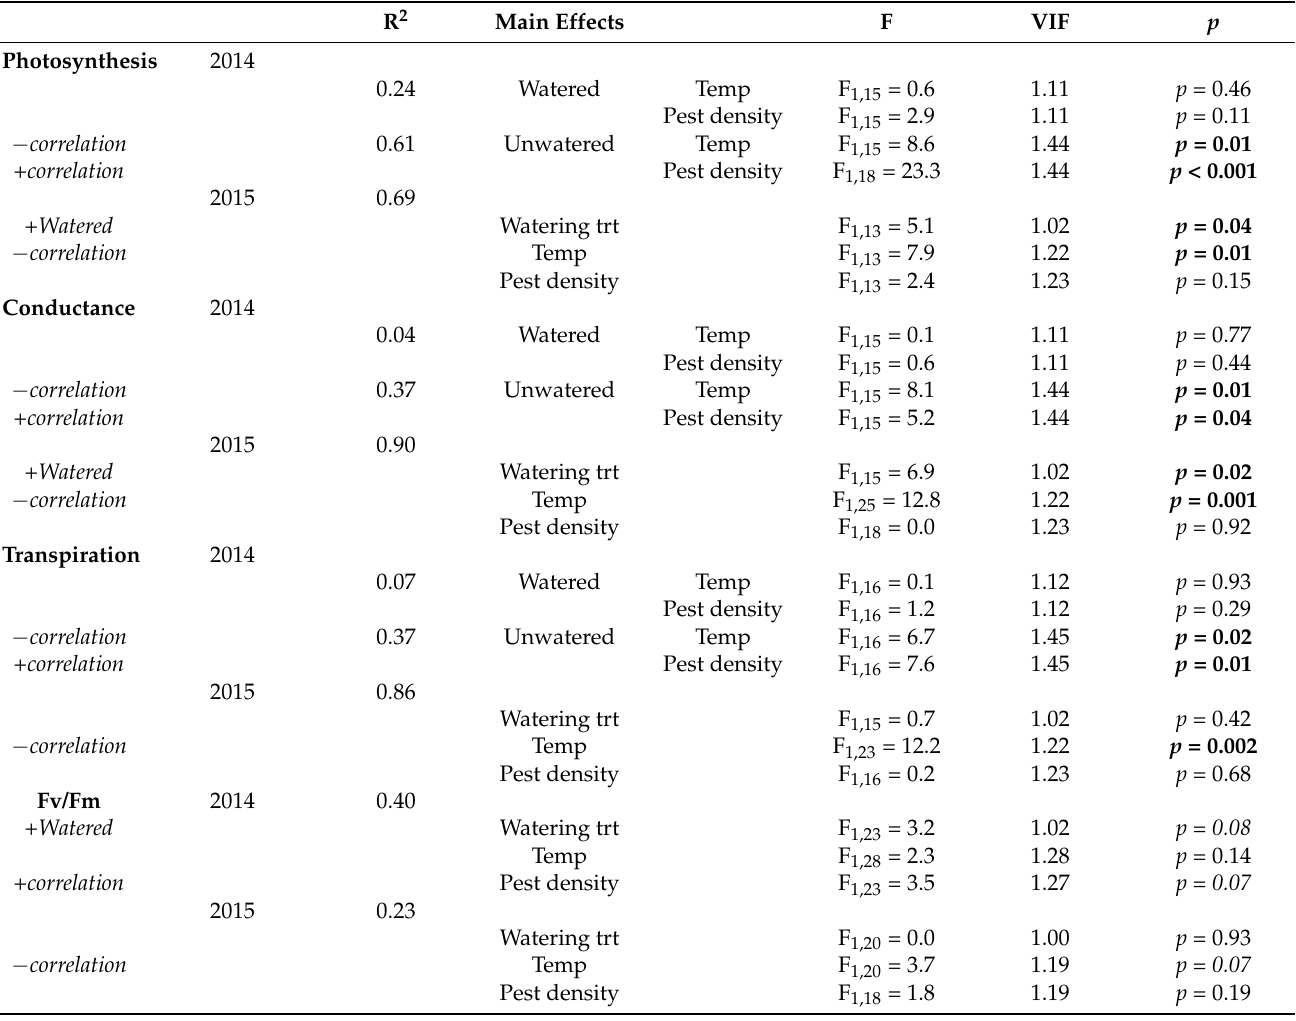
Table 2. Multiple linear regression with tree canopy temperature, M. tenebricosa density, and watering treatment predicting leaf-level processes in 2014 and 2015. If the interaction between watering treatment and temperature was significant ( p < 0.05), separate models were created for each watering treatment. Full model R 2 and variance inflation factors (VIF) for each variable are provided. The directionality of each significant main effect is indicated in the left column. Bolded p -values are statistically significant ( p < 0.05) and italicized p -values are nearly significant ( p < 0.1). R 2 Main Effects F VIF